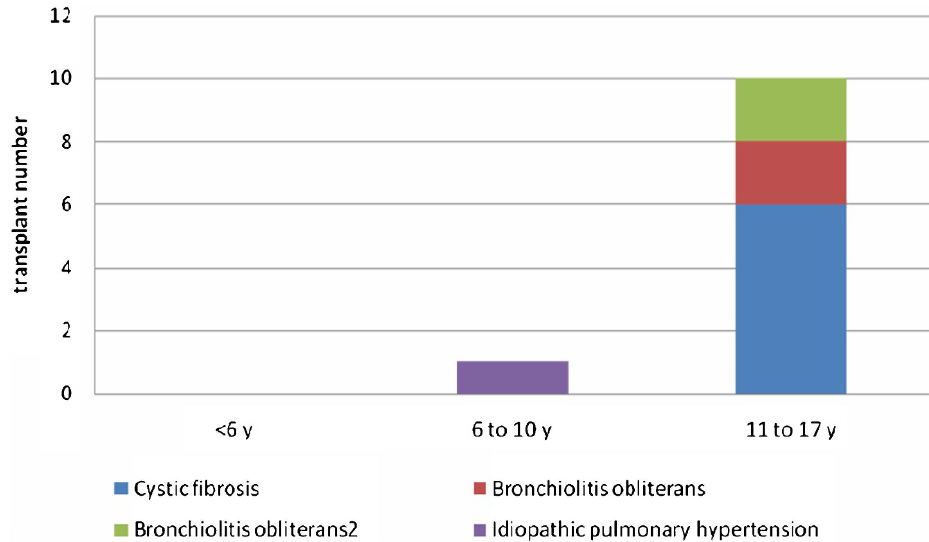
Figure 1 - Distribution of recipients according to age